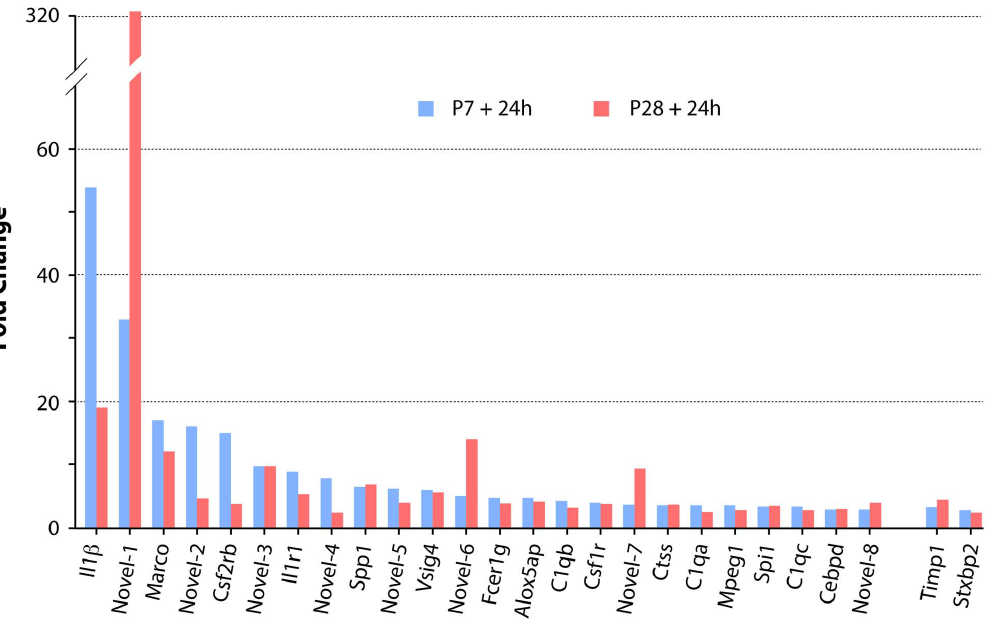
Figure 5. Comparison of expression levels of the twenty-six genes that changed expression in spinal cord 24 h following transection at both P7 and P28. All but two of these genes (Timp1 and Stxbp2) were in the immune/inflammatory category. The magnitude of the expression changes was generally similar at the two ages, but more genes (six: IL1 b , MARCO, novel-2, CSF2RB, IL1-R1, novel-4) showed greater upregulation at P7 than at P28 (three: novel-1, novel-6, novel-7). A search of Ensembl, NCBI ‘‘Gene’’ and GO categories showed that all of these novel genes are involved in immune/inflammatory functions (see Tables S1 and S2).